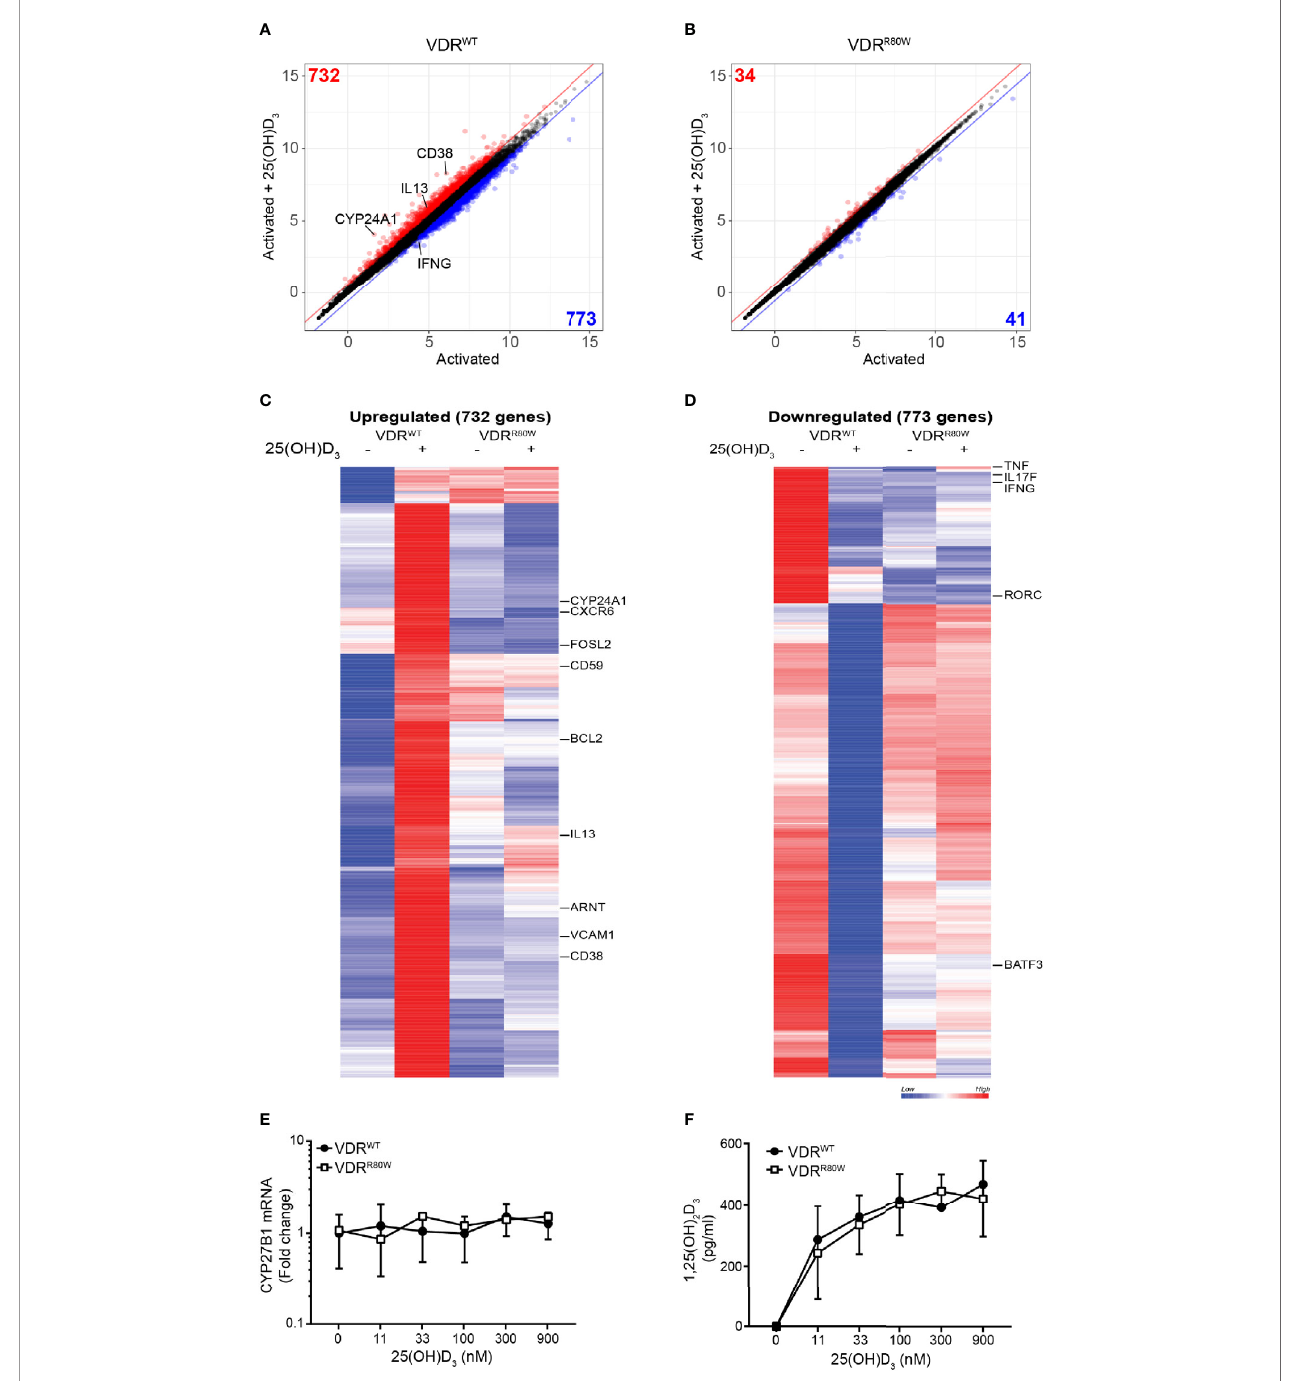
FIGURE 2 | The R80W mutation abolishes normal 1,25(OH) 2 D 3 -mediated gene up- and down-regulation Regularized log2 normalized gene expression in (A) VDR WT and (B) VDR R80W CD4 + T cells activated in the presence or absence of 25(OH)D 3 . The red and blue lines indicate the 1.5-fold threshold for up- and down-regulated genes, respectively. Genes that are at least 1.5-fold up- or down-regulated by 25(OH)D 3 are colored red or blue, respectively, and the number of genes up- or down-regulated by 25(OH)D 3 is indicated in the respective corners. Heatmap of genes up- (C) and down-regulated (D) by 25(OH)D 3 in VDR WT CD4 + T cells. Selected genes are indicated to the right of the heatmaps. (E) CYB27B1 mRNA and (F) 1,25(OH) 2 D 3 production in VDR WT (black circles) and VDR R80W (white squares) CD4 + T cells activated in the presence of the indicated concentration of 25(OH)D 3 . (E) The expression levels are given as fold change normalized to the average expression level of VDR WT in control cells activated in the absence of 25(OH)D 3 . Mean ± SD (VDR WT n = 6; VDR R80W n = 1). (F) Mean ± SD (VDR WT n = 6; VDR R80W n =